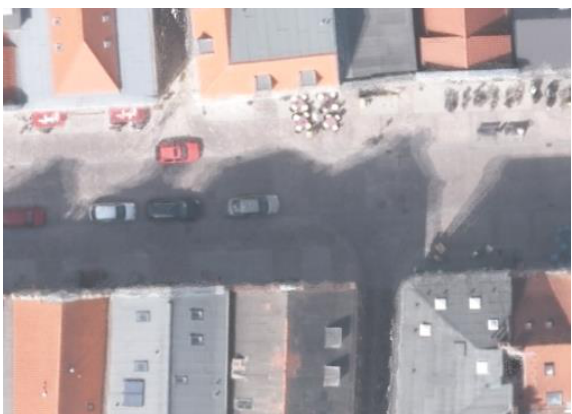
Figure 18. TrueDOP presentation without occluded